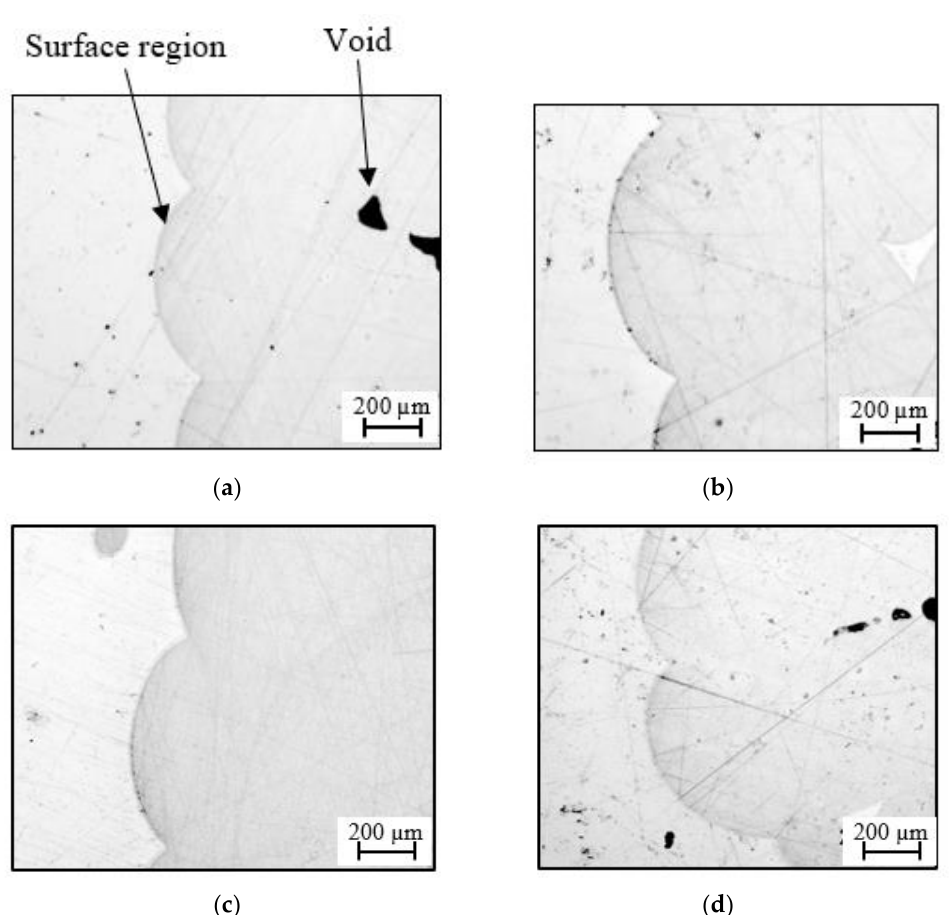
Figure 4. Cross-sections of the surface regions of the four scaled sizes of lattice structure ( a ) n = 1, ( b ) n = 3/4, ( c ) n = 1/2 and ( d ) n = 1/4.